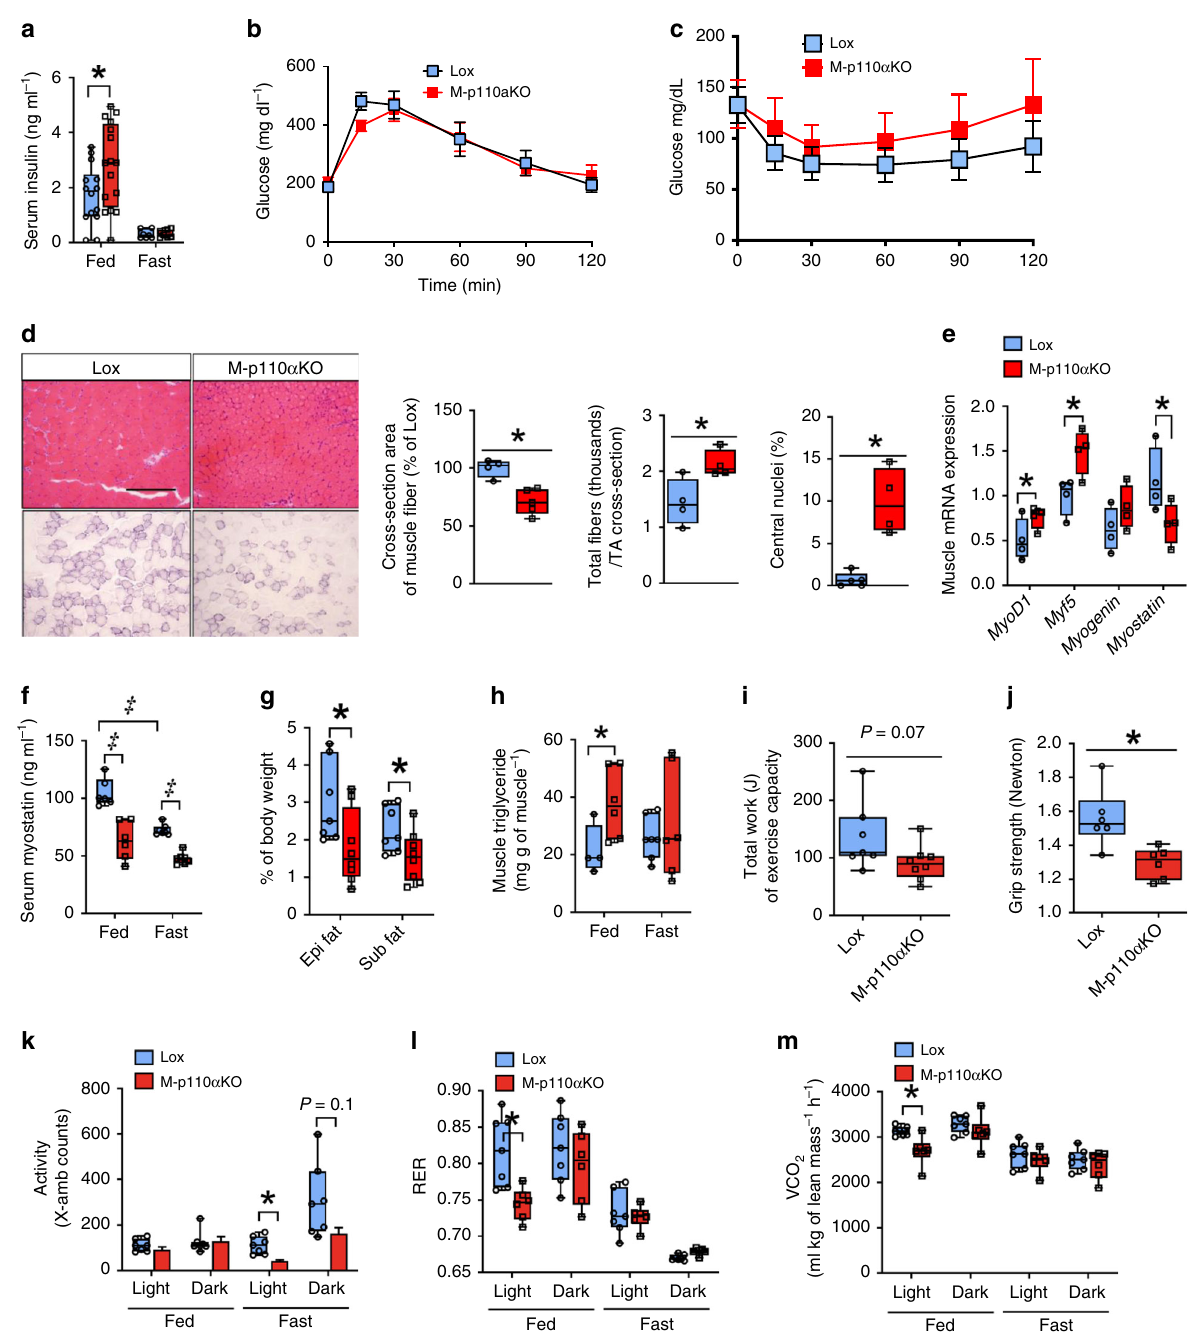
Fig. 6 Hyperinsulinemia, abnormal muscle function, and decreased RER. a Serum insulin levels from M-p110 α KO and control mice fasted for 24 h or randomly fed at 3 months of age (ctrl, n = 5; KO, n = 7). b , c Intraperitoneal glucose tolerance test (GTT) and insulin-tolerance test (ITT) ( c ) performed in M-p110 α KO and control mice at 3 months of age on chow diet (CD) (ctrl, n = 5; KO, n = 8). d H&E stain in quadriceps and succinate dehydrogenase (SDH) stain in TA muscle cross-sections of M-p110 α KO and control mice at 3 months of age (scale bar = 200 μ m), and quanti fi cation of the muscle fi ber cross- section area from H&E stain, total fi ber numbers per area of TA muscle cross-section from SDH stain, and percentage of quadriceps myo fi bers with central nuclei from H&E stain ( n = 5). e mRNA expression of myogenic factors in TA muscles from 3-month-old M-p110 α KO and control mice ( n = 5). f Serum myostatin levels from 3-month-old M-p110 α KO and control mice fasted for 24 h or randomly fed (ctrl, n = 5; KO, n = 7). g Percentage of epididymal fat and subcutaneous fat weights per body weight of M-p110 α KO and control mice at 3 months of age ( n = 8). h Triglyceride levels in gastrocnemius muscles of 3- month-old M-p110 α KO and control mice fasted for 24 h or randomly fed (ctrl, n = 4; KO, n = 9). i The total work of M-p110 α KO and control mice from acute treadmill test at 16 months of age ( n = 8). j Forelimb grip strength from 16-month-old M-p110 α KO and control mice ( n = 8). k – m Spontaneous activity (k), respiratory exchange ratio (RER) (l), and VCO 2 (m) in 24-month-old M-p110 α KO and control mice during fed and fast cycles over 48 hrs in CLAMS metabolic cages (ctrl, n = 5; KO, n = 6). * P < 0.05 by Student ’ s t test; ‡ P < 0.05 by two-way ANOVA. Light blue bars represent p110 α - fl oxed mice; red bars represent M-p110 α KO mice. TA tibialis anterior, Gastroc gastrocnemius, Quad quadriceps, EDL extensor digitorum longus. Box plots visualize the fi ve-number summary of the data set (minimum, lower quartile, median, upper quartile, and maximum). The data are mean ± SEM